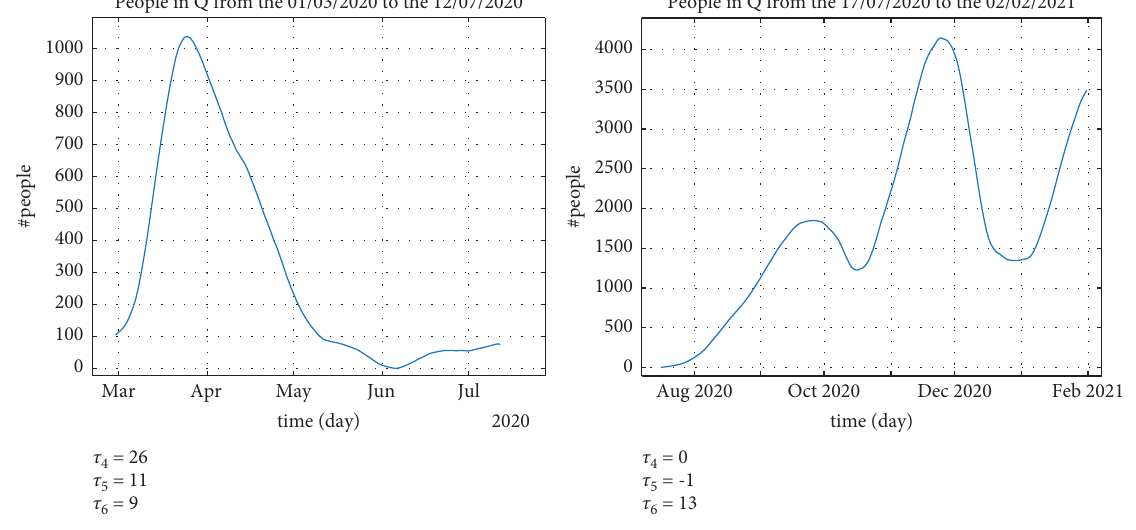
Figure 5: Estimated people in quarantine after testing positive for COVID-19 at different time periods. Table 3: Estimated parameters via linear regression.